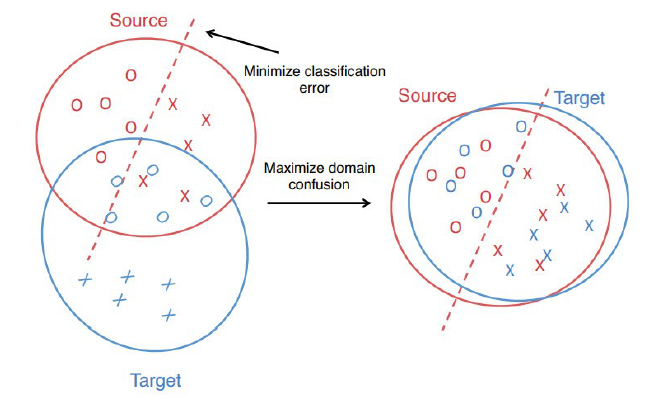
Figure 5. Domain